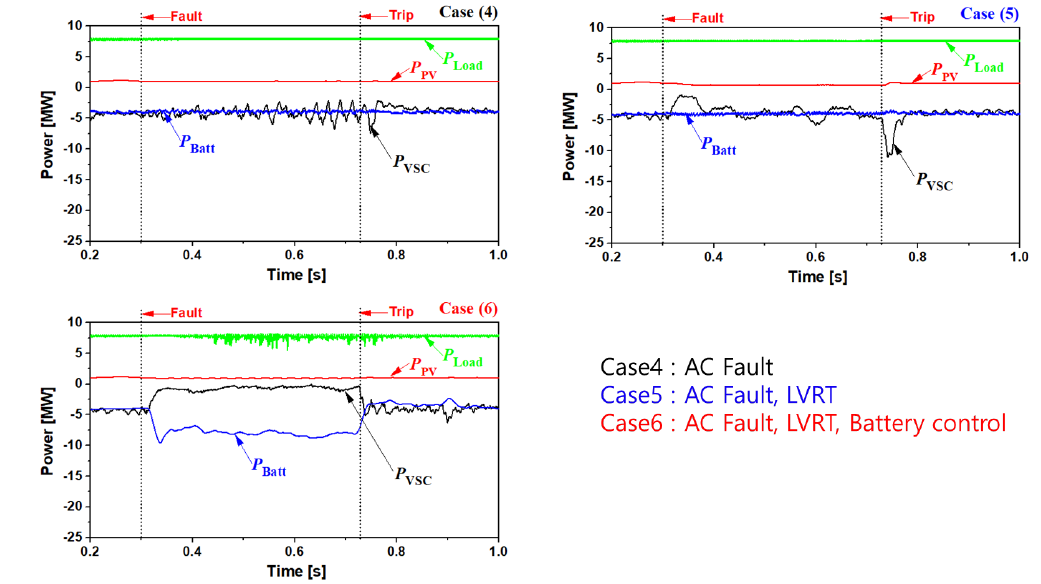
Figure 15. Power Waveform of PV (Photovoltaic), DC Load, Battery and VSC (Voltage Sourced Converter) in Case (4)-(6).